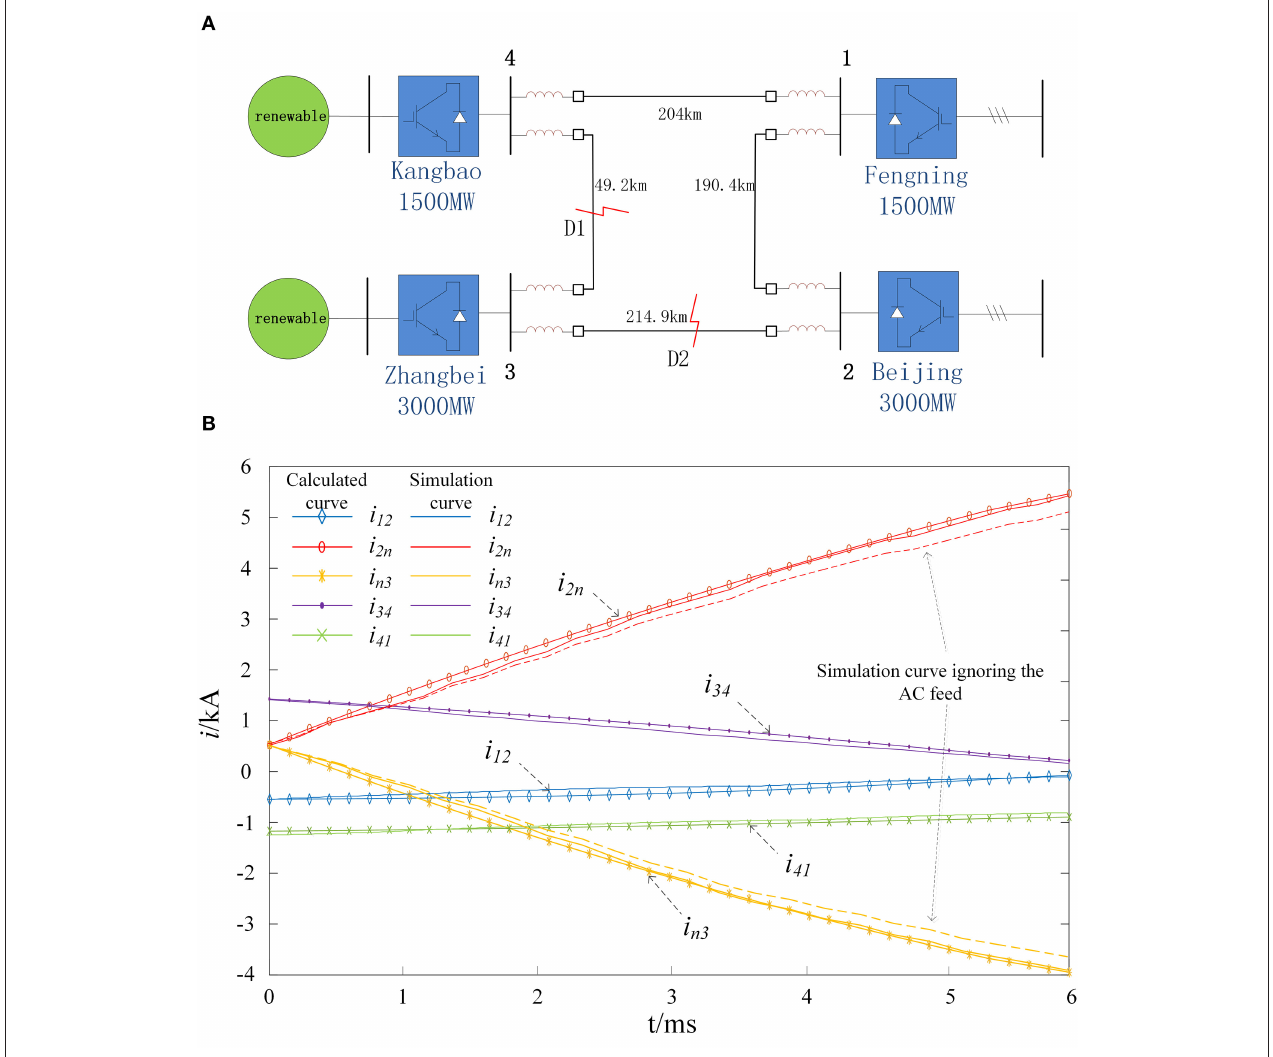
FIGURE 4 | Analysis of DC fault current in MMC flexible DC grid. (A) Four- terminal DC power grid topology. (B) DC line current during the monopolar ground